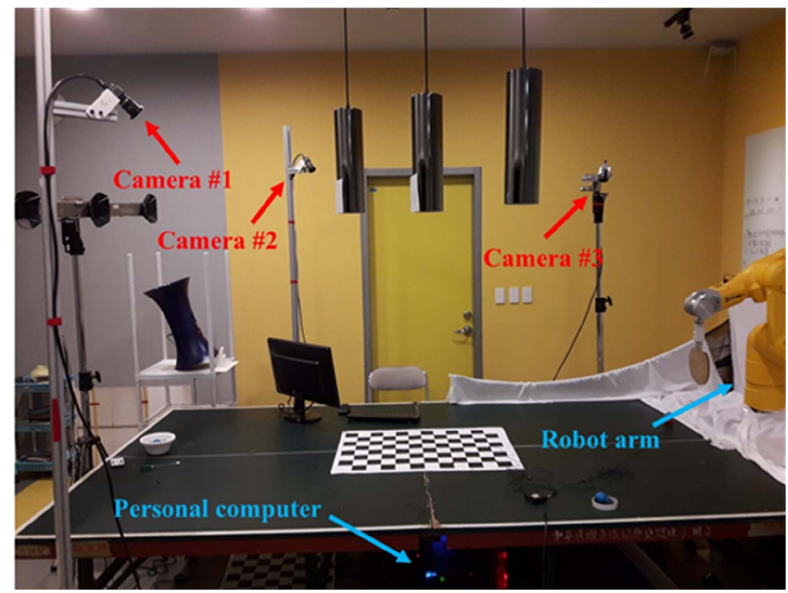
Figure 2. 3D reconstruction system of table-tennis